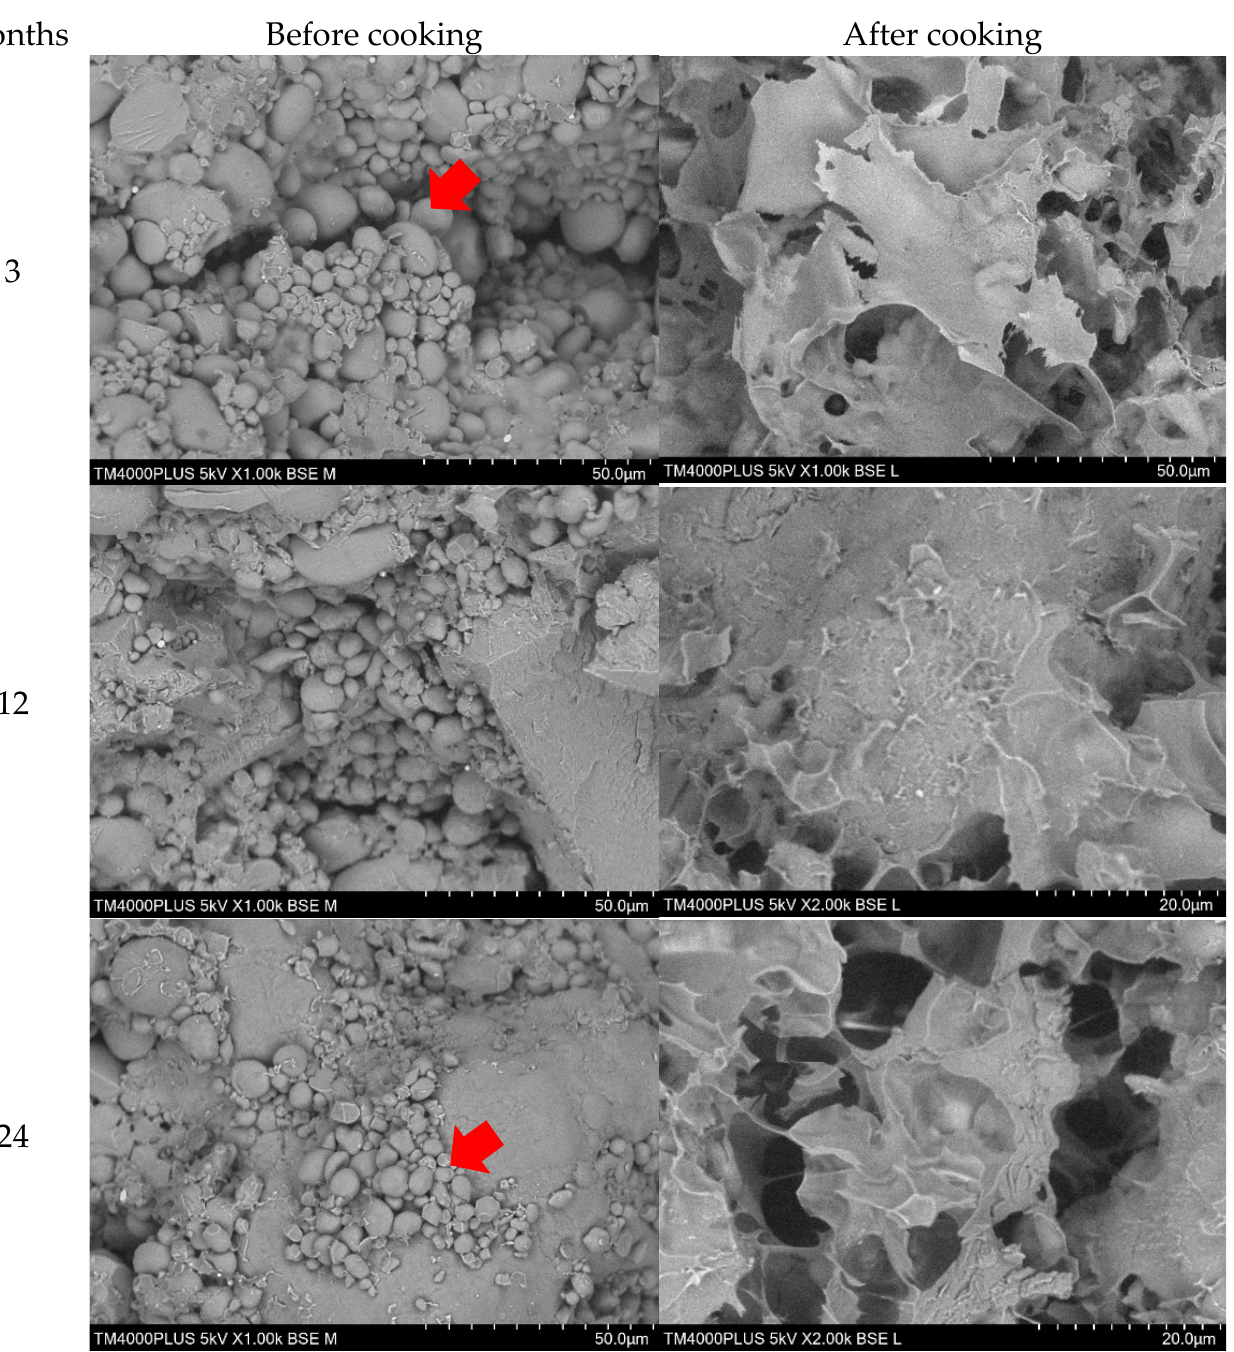
Figure 4. SEM of wheat noodles fortified with isomaltodextrin during different storage periods at 25 °C storage.